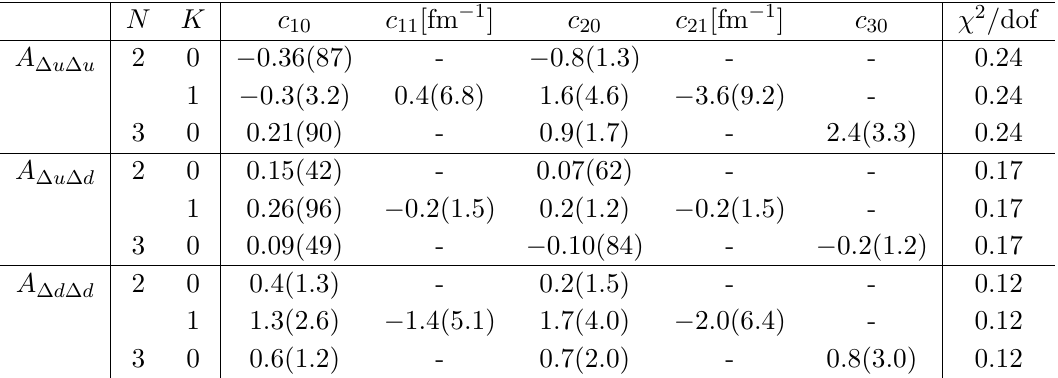
Table 8 . The same as table 7, but for the twist-two function A ∆ q ∆ q 0 .